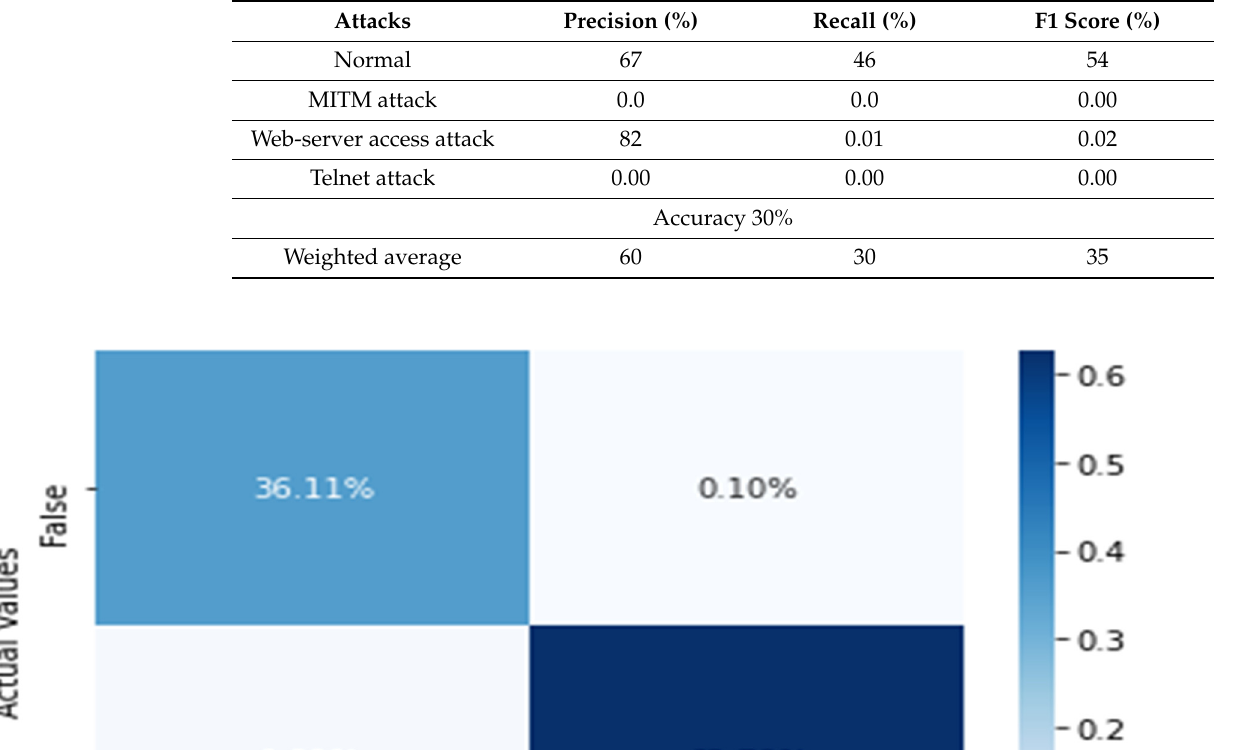
Table 8. Results of logistic regression using the multiclass classification dataset.